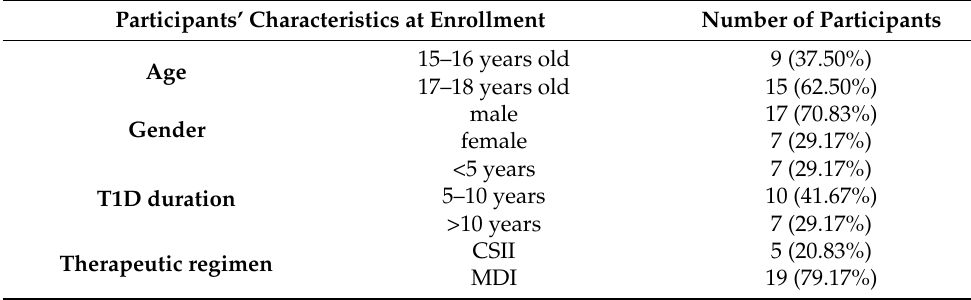
Table 1. Demographic and clinical characteristics of the participants at